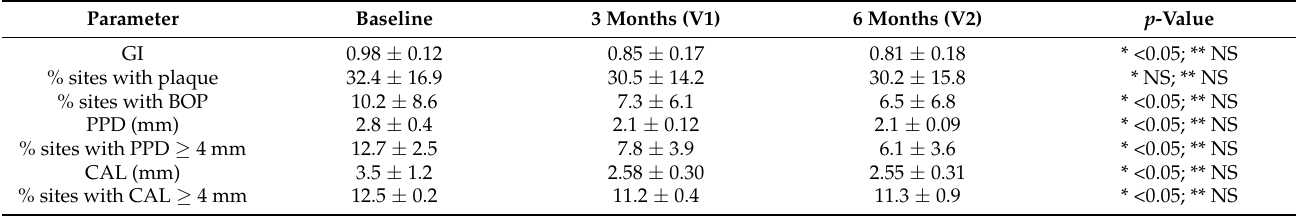
Table 3. Changes in PD-related parameters at 3 and 6 months after